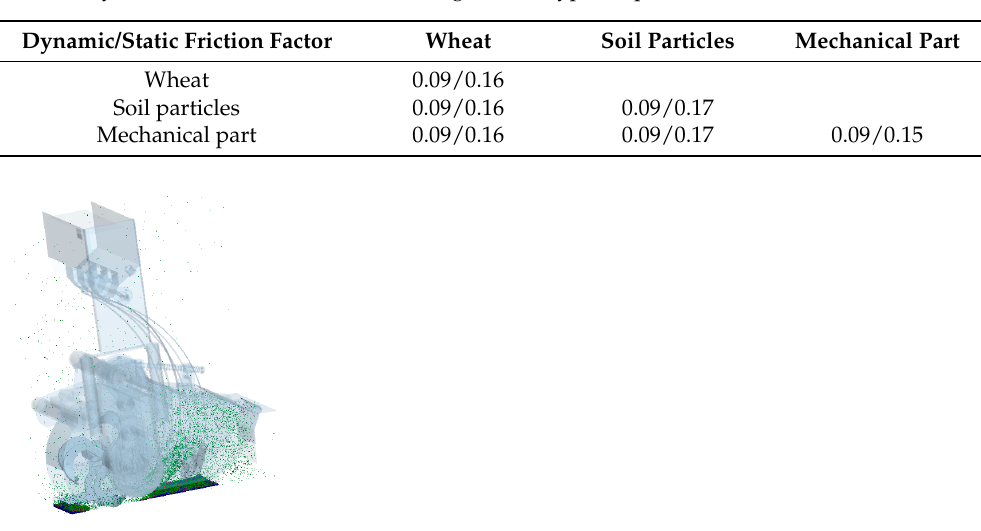
Figure 6. Simulation model of soil throwing and covering device after sowing.